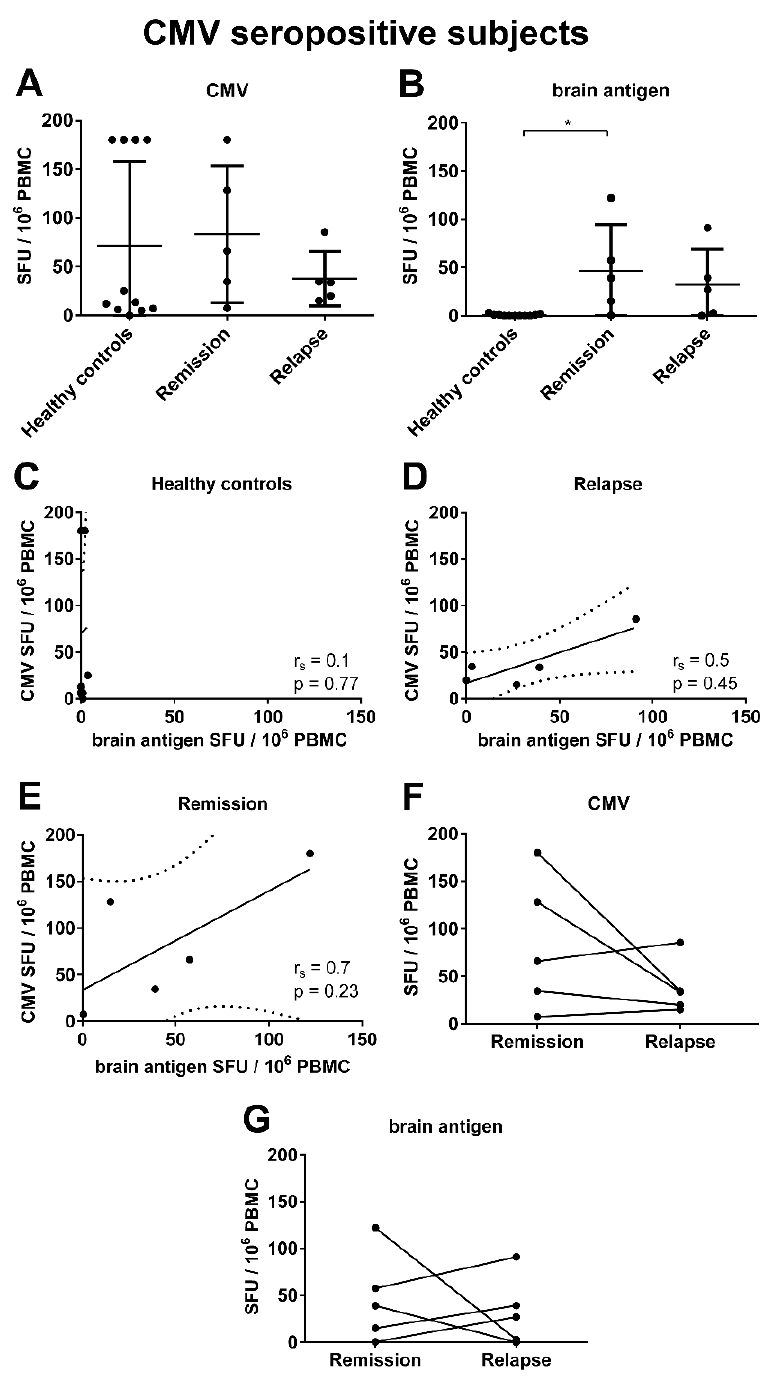
Figure 6. CMV-specific and brain antigen-specific B cell frequencies and correlation analysis with CMV seropositive subjects only. The frequencies of CMV- ( A ) and brain antigen-specific ( B ) B cells were determined in n = 11 healthy controls and n = 5 MS patients experiencing a relapse and in the same MS patients in remission for CMV seropositive subjects only. Spearman’s rank correlation (r s ) analysis for CMV and brain antigen-specific B cell numbers in healthy controls ( C ), MS patients experiencing an acute relapse ( D ) and MS patients in remission ( E ); lines represent the linear regression, and dotted lines the 95% confidence interval. There was a similar magnitude of the CMV- ( F ) and brain antigen-specific ( G ) B cell response in relapse and remission. The results for the individual donors are displayed.